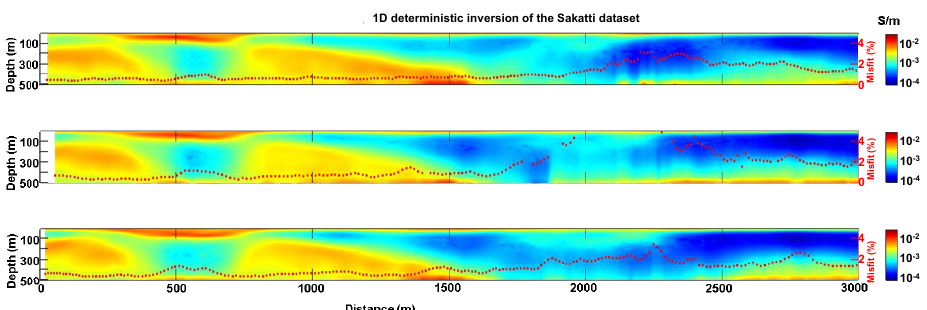
Figure 7. The 1D deterministic inversion of the field data.